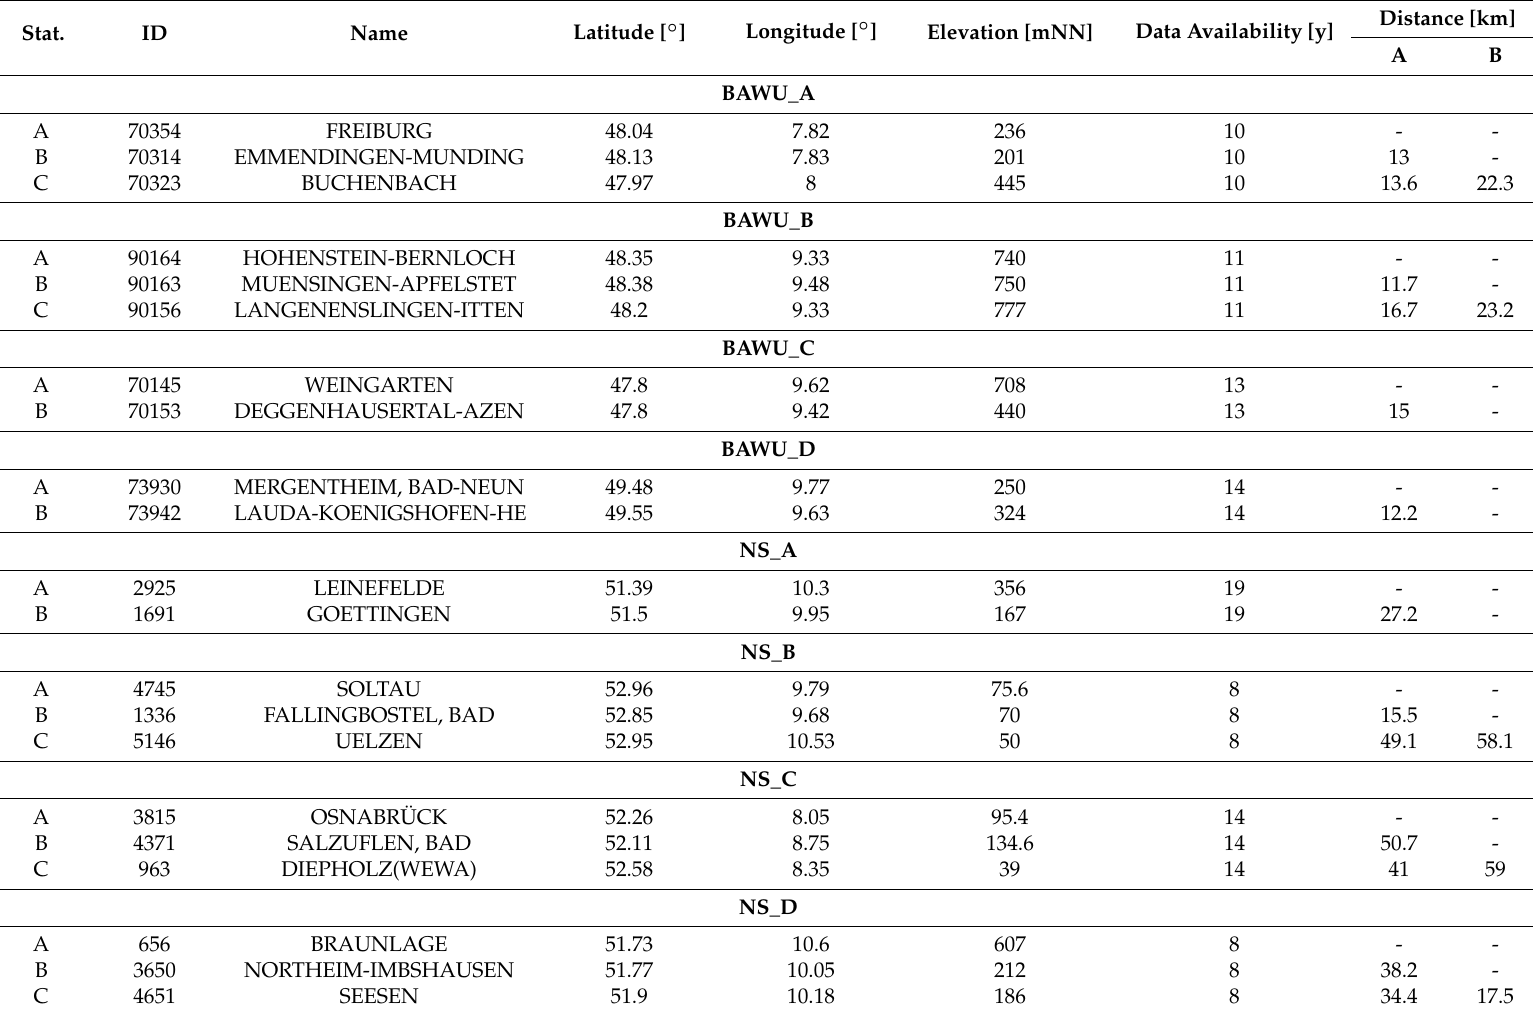
Table 2. Attributes of rainfall stations used for model